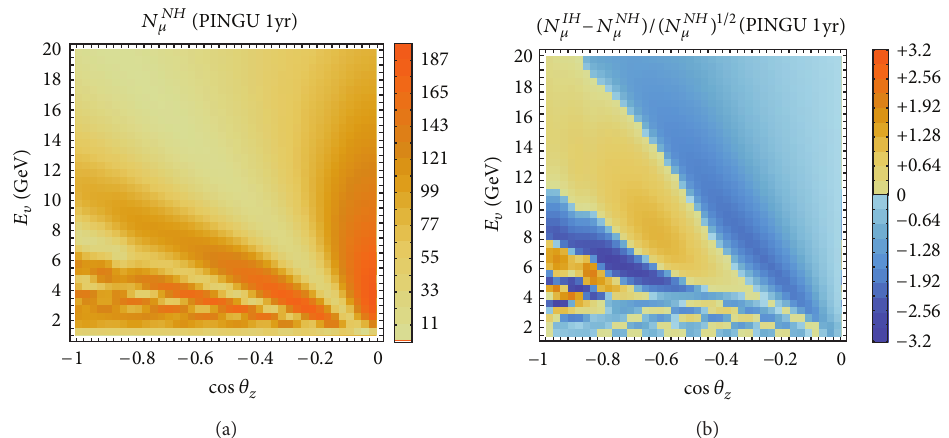
Figure 14: Left: the binned distribution of the number of 𝜇 events in PINGU after 1 year under the assumption that the neutrino hierarchy is normal. Right: the 𝑁 - 𝐼 hierarchy asymmetry of ] 𝜇 events in the 𝐸 ] -cos 𝜃 𝑧 plane. Theabsolute value of theasymmetry ina given bin determines the statistical significance of the difference of the numbers of events for the inverted and normal mass hierarchies. Both figures from [56].